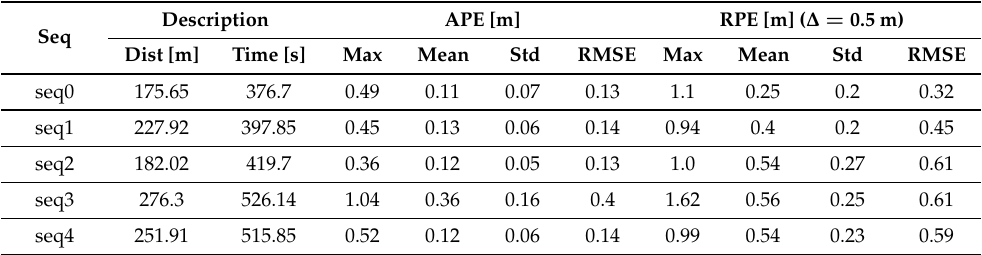
Table 5. Algodonales dataset description and localization errors.